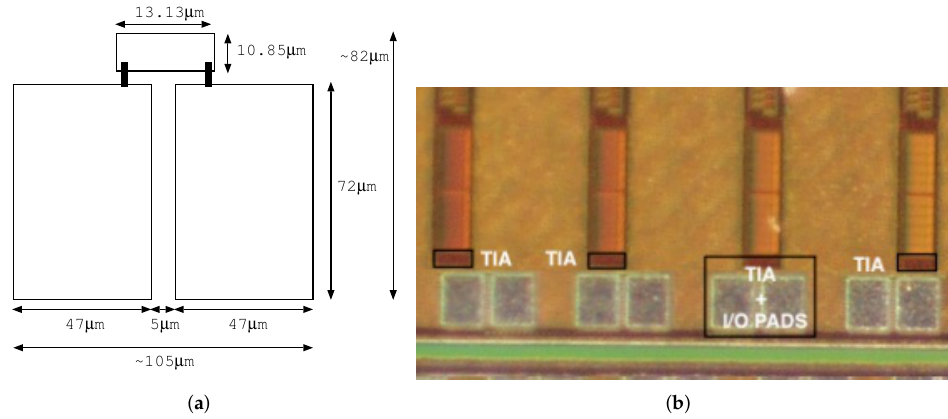
Figure 10. Die photograph of the input and output analog pad area, including the layout of the transimpedance amplifier. ( a ) Relevant dimensions of TIA and I/O pads, and ( b ) microphoto of the fabricated die.